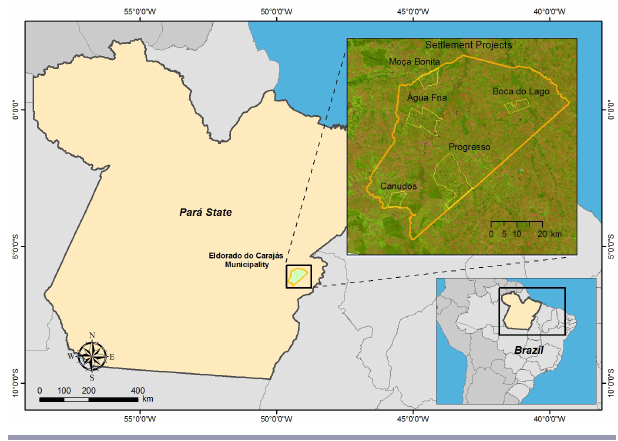
Fig. 2 . Case study municipality and selected settlement projects. Source: INPE 2011, INCRA 2012.